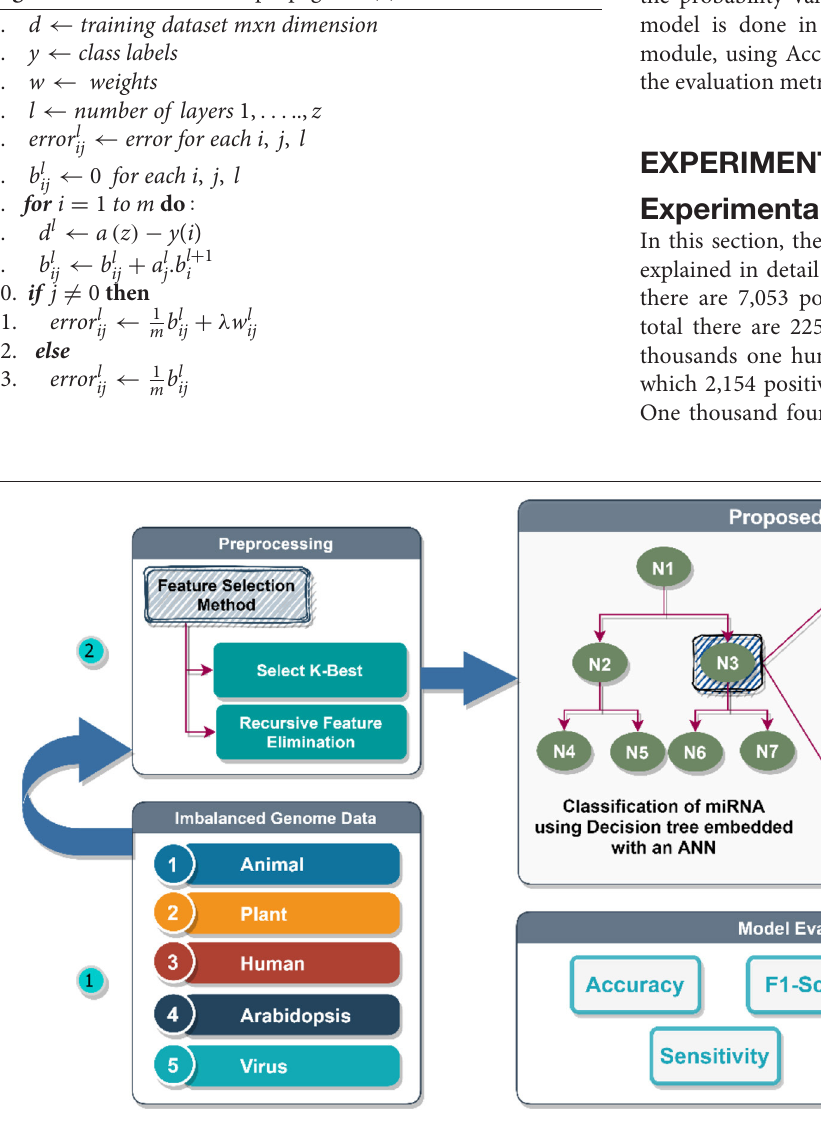
FIGURE 3 | Proposed H-DNN